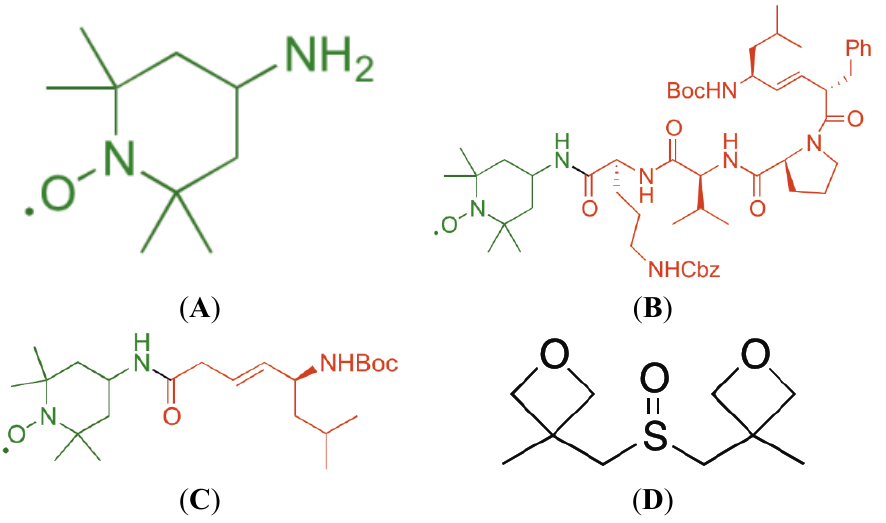
Figure 1. Structures of 4-Amino-Tempo ( A ); XJB-5-131 ( B ); JP4-039 ( C ); and MMS350 ( D